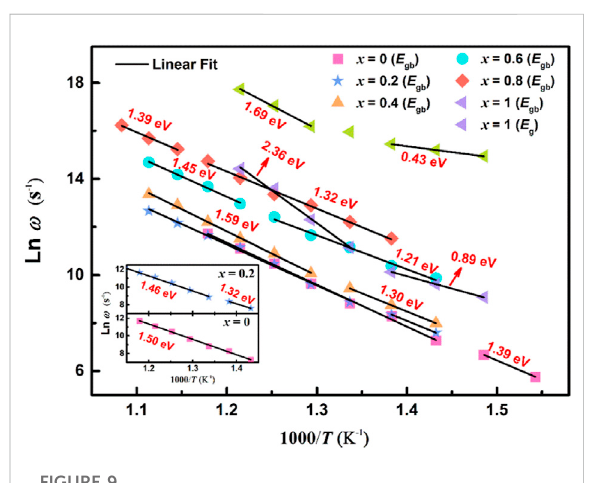
FIGURE 9 (Color online) The relaxation frequency Arrhenius diagram for (1- x ) BBT - x BiT ceramics at different